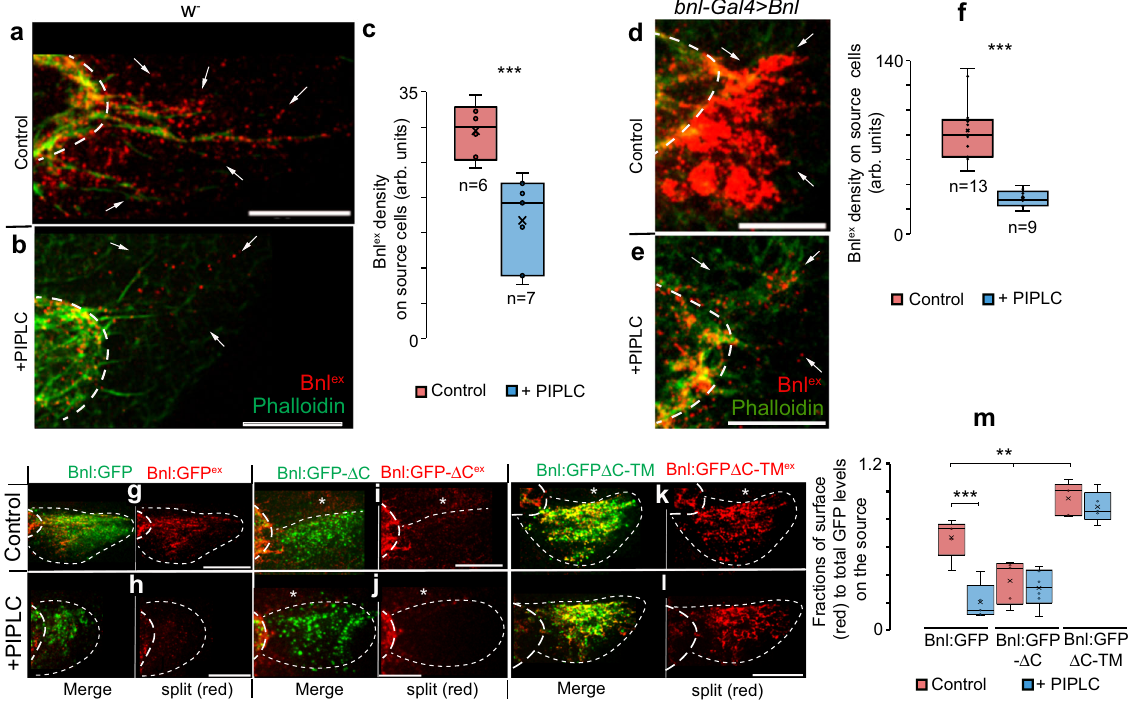
Fig. 5 Bnl is GPI-anchored to the wing disc source cell surface. a – c Wing discs ( w − showing surface-localized native Bnl ex (red, α Bnl ex ) levels on the bnl - source area (arrows) before ( a ) and after ( b ) PI-PLC treatment; c box plots comparing numerical values as indicated, p = 0.0013 (**; unpaired two-tailed t test). d – f Wing discs overexpressing Bnl under bnl-Gal4 showing surface Bnl ex (red, α Bnl ex ) levels on the bnl -source (arrows) before ( d ) and after ( e ) PI- PLC treatment; f box plots comparing numerical values as indicated, p = 0.024 × 10 − 4 (***; unpaired two-tailed t test). g – m Source surface levels (red,